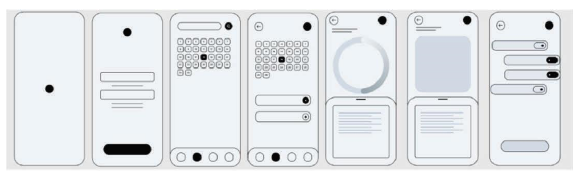
Figure 4: Low-quality wireframe.